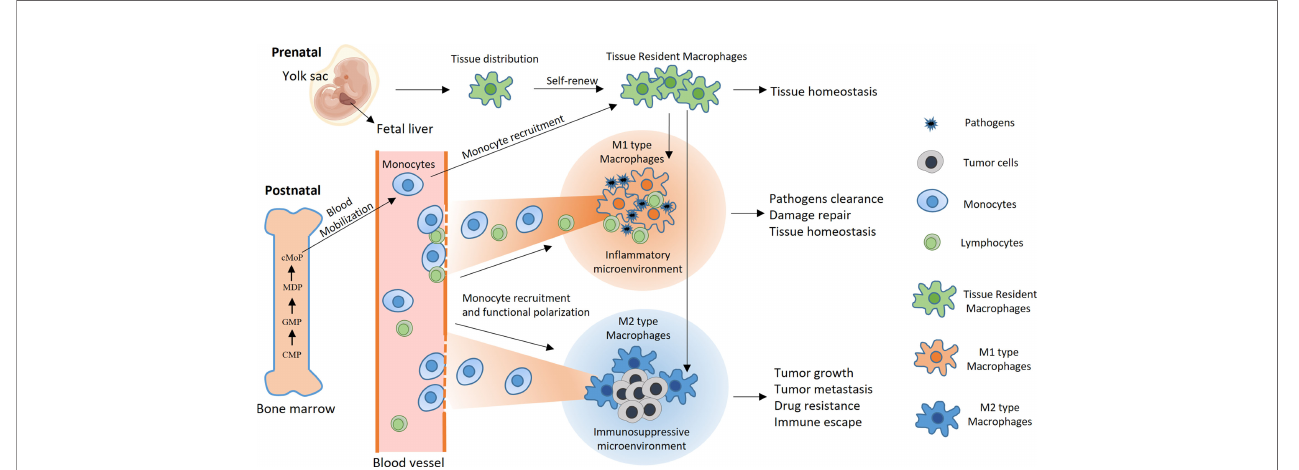
FIGURE 1 | Development, differentiation, and function of macrophages. Under physiological conditions, macrophages are highly versatile and widely present in almost all tissues and organs. Some macrophages that reside in tissues are called TREMs. TREMs originate mainly from yolk sac macrophage progenitors and fetal liver macrophages during embryonic development. After birth, TREMs maintain their number partially through self-renewal and sometimes through the recruitment of monocyte-derived macrophages. Pluripotent hematopoietic stem cells in bone marrow develop into monocytes through multiple stages, including common myeloid progenitors (CMPs), granulocyte-macrophage progenitors (GMPs), macrophage and dendritic cell precursors (MDPs), and common monocyte progenitors (cMoPs). In typical in fl ammation caused by pathogen infection, monocytes are mobilized from the bone marrow into the blood circulation and subsequently recruited into in fl ammatory sites, where they differentiate into M1 macrophages and ef fi ciently phagocytose the pathogen. In fl ammation also recruits lymphocytes and initiates antigen-speci fi c immune responses with the help of macrophages and dendritic cells, ultimately resulting in pathogen clearance. At the late stage of in fl ammation, macrophages differentiate toward the M2 type and participate in the tissue repair process, leading to the restoration of internal homeostasis. In contrast, monocytes and TREMs preferentially differentiate toward M2 polarization after they enter the tumor microenvironment, wherein they promote tumor growth and metastasis, mediate resistance to cancer treatments and inhibit antitumor immune